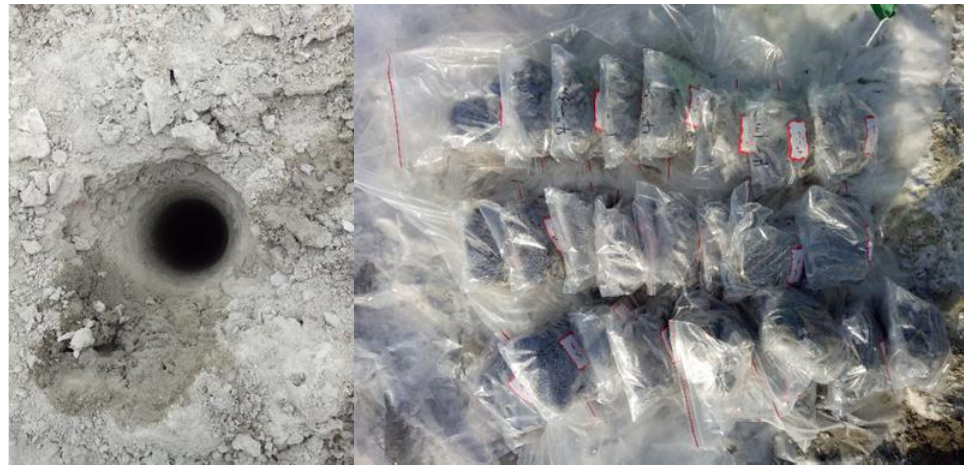
Figure 2. Morphology and sample map of sampling sites in tailings pond.